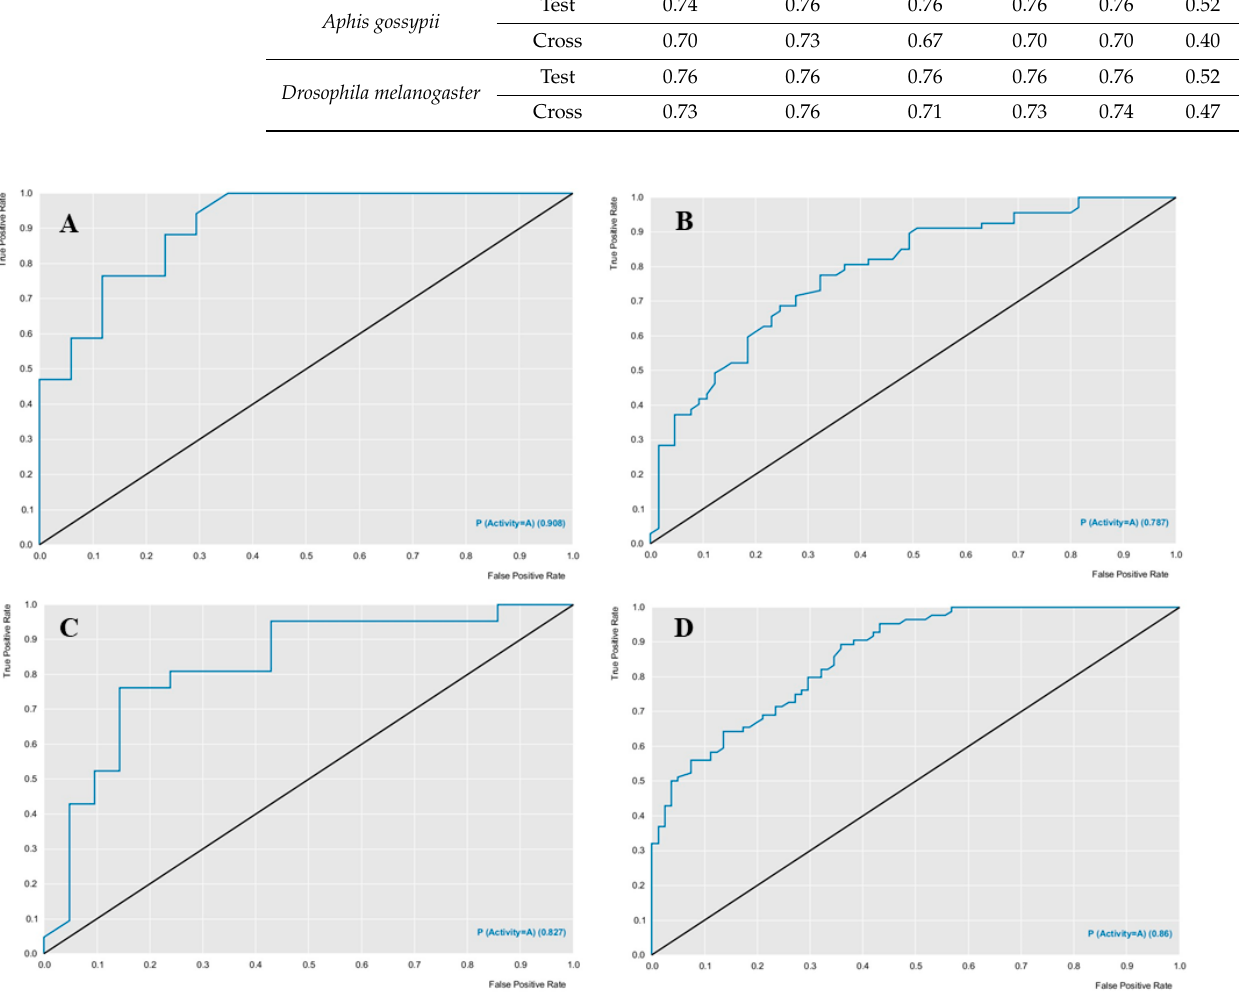
Figure 6. ROC curves generated from the RF models, for each species studied. ROC curve of Aphis gossipy Test ( A ) and Cross ( B ), and Drosophila mel-anogaster Test ( C ) and Cross ( D